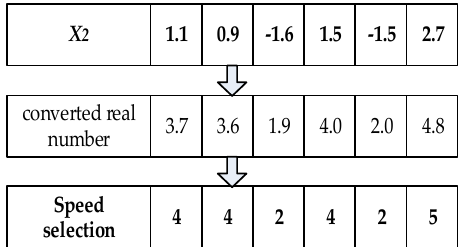
Figure 5. The conversion process from individual position vector to speed-level selection.